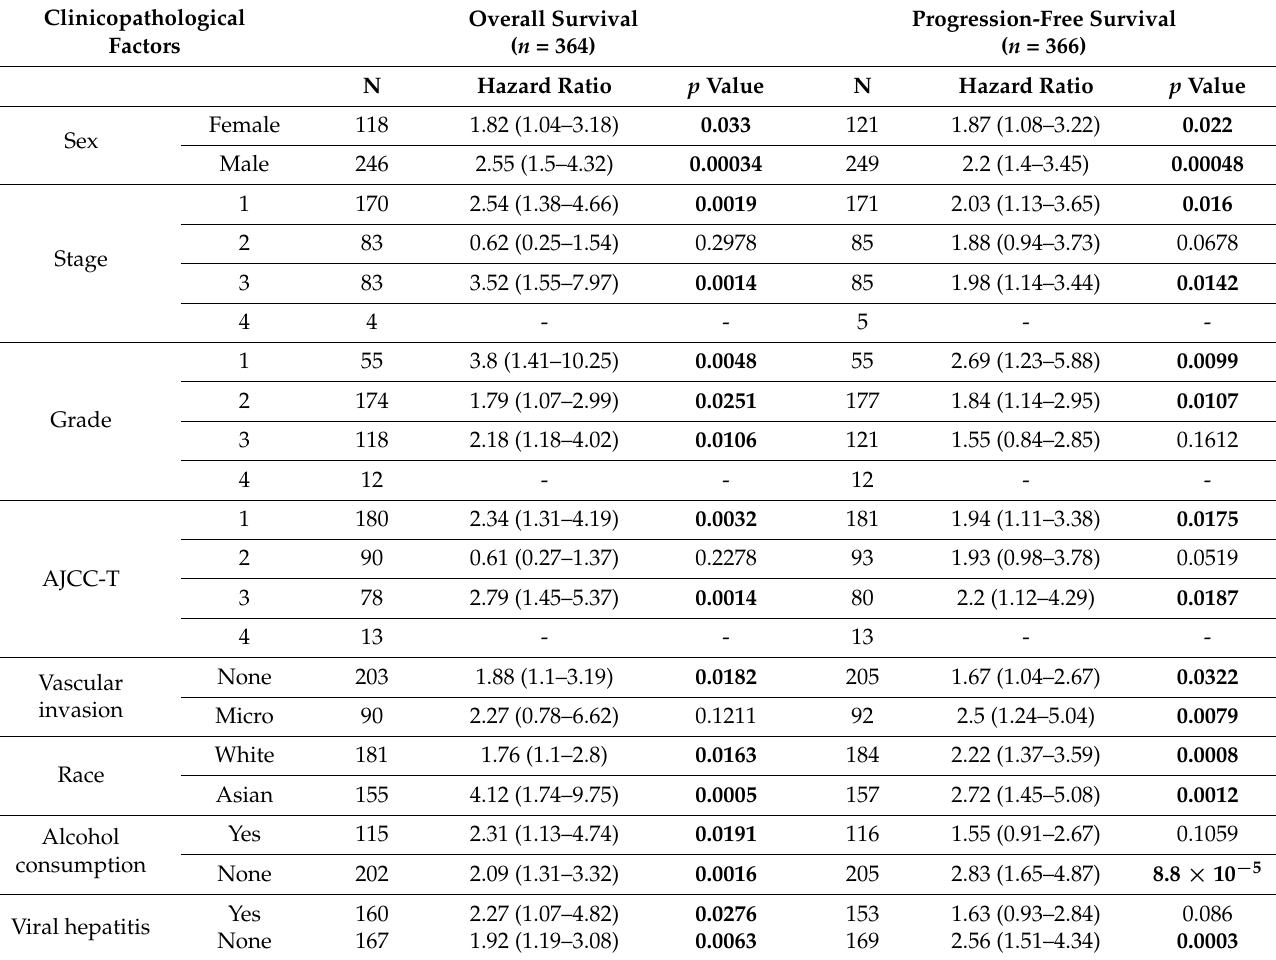
Table 1. Correlation analysis of FKBP1A expression and prognostic overall survival in LIHC patients with different clinic-pathological factors by using Kaplan–Meier